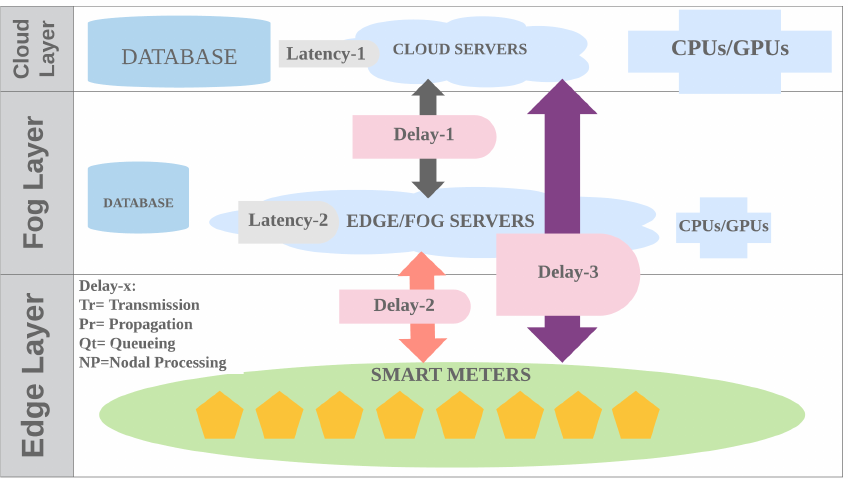
Figure 10. Delay and Latency in fog/edge and cloud server architecture.